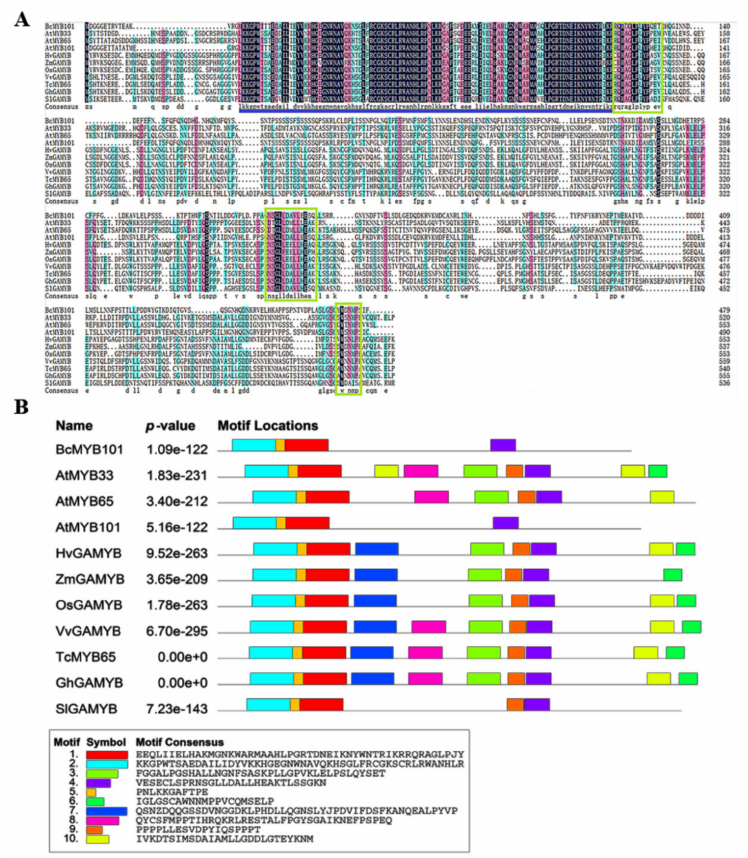
Figure 1. Multiple sequence alignment and motif compositions of GAMYB genes. ( A ) Sequence alignment of GAMYB proteins in Hordeum vulgare ( Hv ), Solanum lycopersicum ( Sl ), Oryza sativa ( Os ), Vitis vinifera ( Vv ), Zea mays ( Zm ), Arabidopsis thaliana (At ), Gossypium hirsutum ( Gh ), Theobroma cacao ( Tc ), and pak choi ( Brassica rapa ssp. Chinensis ; Bc ). The conserved R2R3 domain of GAMYB and GAMYB-like proteins is marked above the blue line, while conserved Box1, Box2, and Box3 are represented in green boxes. ( B ) Distribution of the conserved motifs of GAMYB genes. The sequences of the 10 motifs are exhibited at the